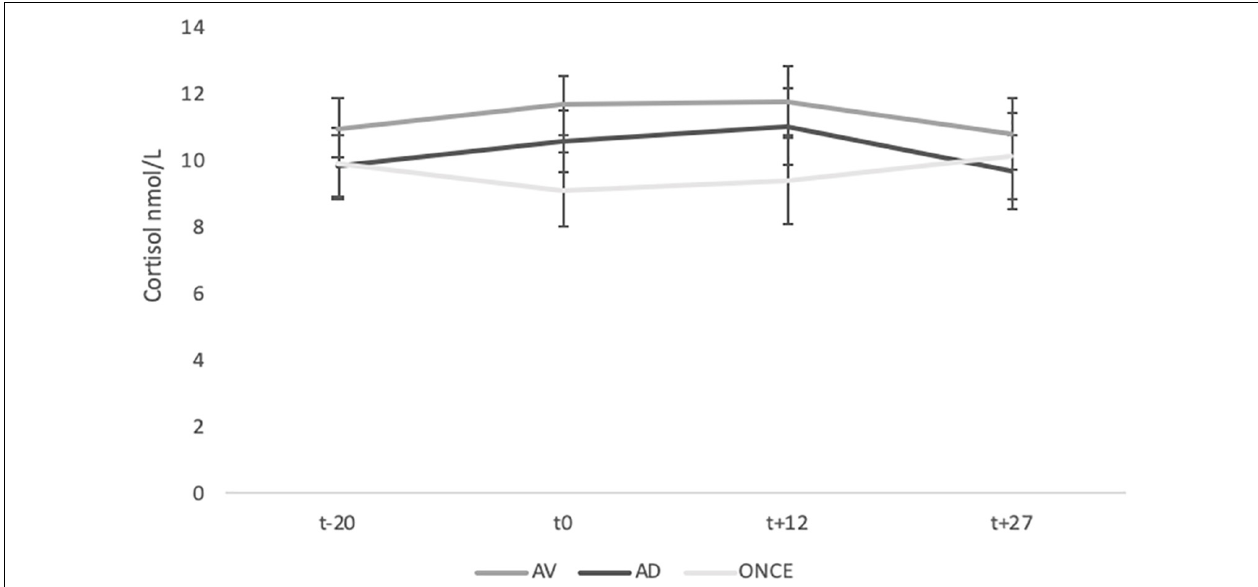
FIGURE 2 | Means of salivary cortisol levels at the different phases of the experimental protocol for each group. Error bars represent standard error of the mean (SEM).